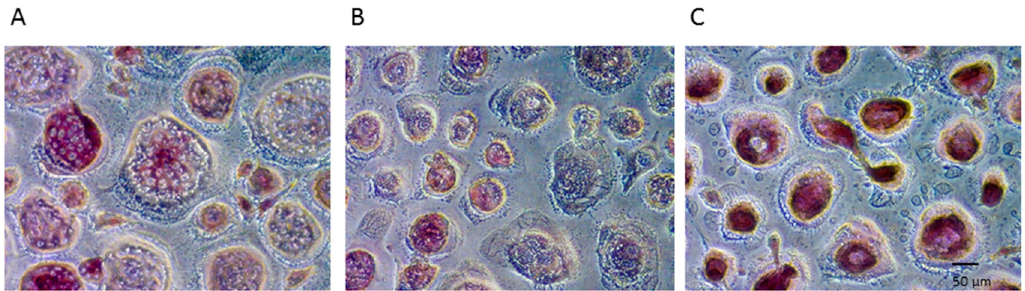
Figure 1. Histochemical detection of most representative staining for TRAP in PBMC -M-CSF/RANKL ( A ), PBMC +M-CSF/RANKL ( B ), and PBMC +M-CSF/RANKL + DMAB ( C ).